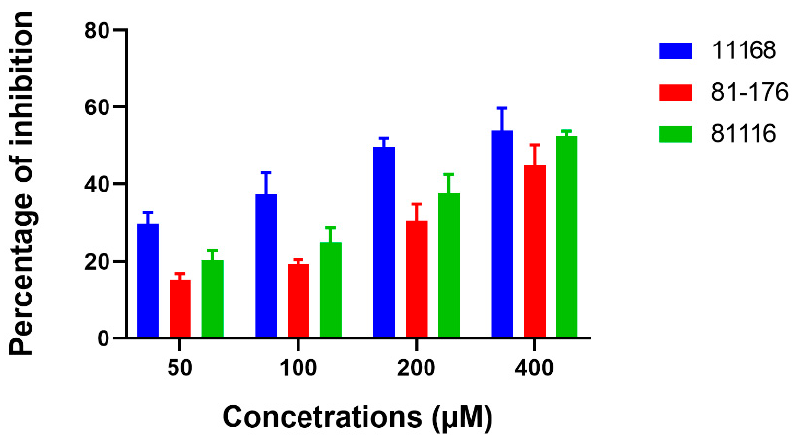
Figure 3. Inhibition of biofilm formation by different C. jejuni strains in the presence of 50–400 μ M ex-c-di-GMP. C. jejuni 11168-O (11168), C. jejuni 81-176 (81-176), and C. jejuni 81116 (81116). Data are presented as mean ± standard error (3 or more biological repeats) of the percentage of inhibition (normalized to untreated control). 3.4. Extracellular c-di-GMP Treatment Effects Auto-Aggregation of C. jejuni Untreated and cultures treated with ex-c-di-GMP were visually examined for visible cell–cell clumping and aggregation. Next, 200 µ M ex-c-di-GMP-treated culture of C. jejuni 11168-O displayed significantly ( p = 0.029 and 0.022, respectively) less auto-aggregation, compared to the untreated culture (Figure 4).